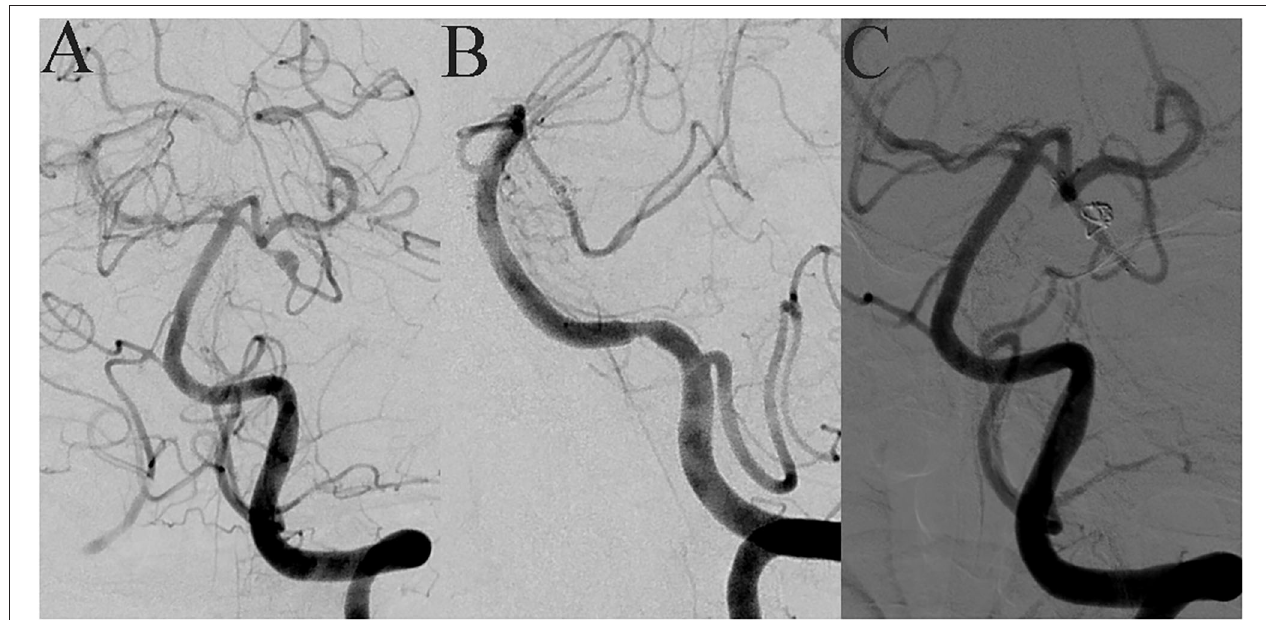
FIGURE 2 | A 42-year-old female suddenly developed severe headache with nausea and vomiting when she was 7 months’ pregnant. MRA showed an intracranial tiny aneurysm, and she underwent conservative treatment. Seventeen months later, she came to our hospital for interventional embolization. DSA showed a